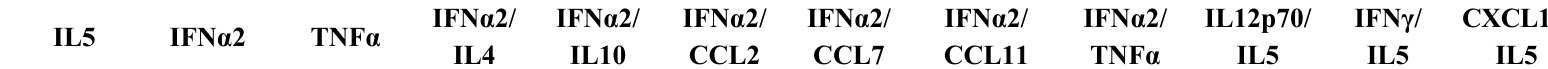
Table 2. Spearman correlations of pretreatment levels of 25OHD with cytokines and ratios in women diagnosed with invasive breast cancer. Variable